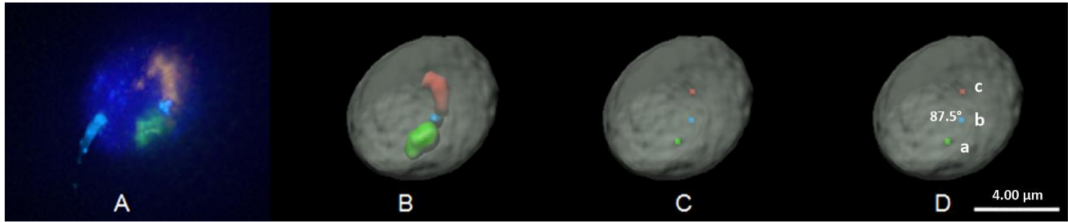
Figure 2. 3D FISH imaging and model rendering demonstrating the hairpin-loop configuration for chromosome 2 in a human sperm nucleus. FISH probes utilized corresponded to the centromere (aqua), p-arm (green), q-arm (red) of chromosome 2. The nucleus is counterstained with DAPI (blue: A) and is pseudo-colored (gray: B, C, and D) in 3D rendered models. ( A ) Depicts the raw FISH image following deconvolution (note: aqua signal at position 8 o’clock is background fluorescence from the sperm tail and is removed from 3D rendered models [panels B, C, and D], note the sperm tail was only visible in a small proportion of cells precluding assessment of longitudinal positioning). ( B ) Provides the 3D model reconstruction from the raw deconvolved image (A). ( C ) Depicts the geometric center for each of the three FISH probe targets as determined by the Imaris software. ( D ) Illustrates how the angle of the hairpin-loop configuration is calculated by measuring the angle formed between the p-arm (point